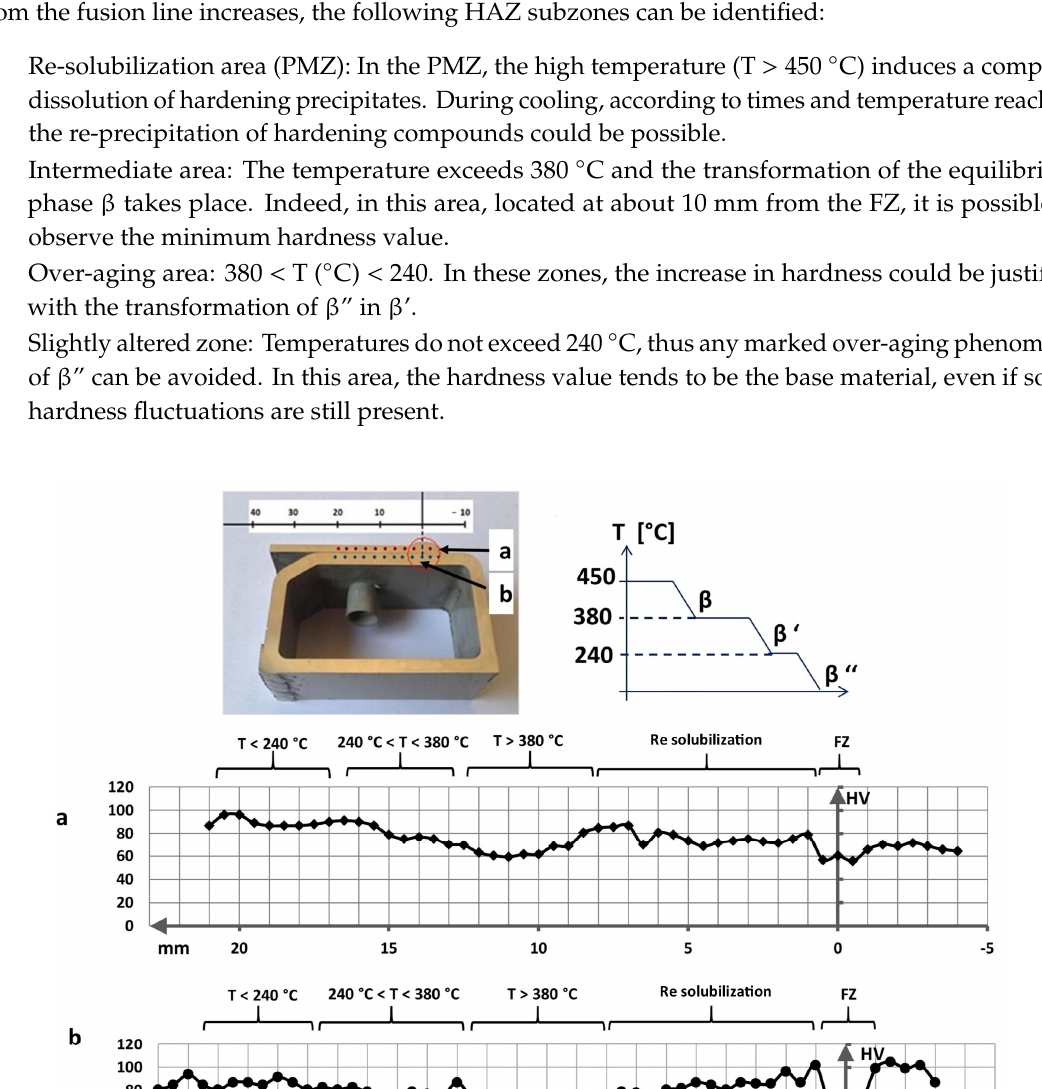
Figure 12. Evolution of the micro-hardness HV in the E-C sub-frame combination as a function of the position along a transverse section of the weld (MIG joint).